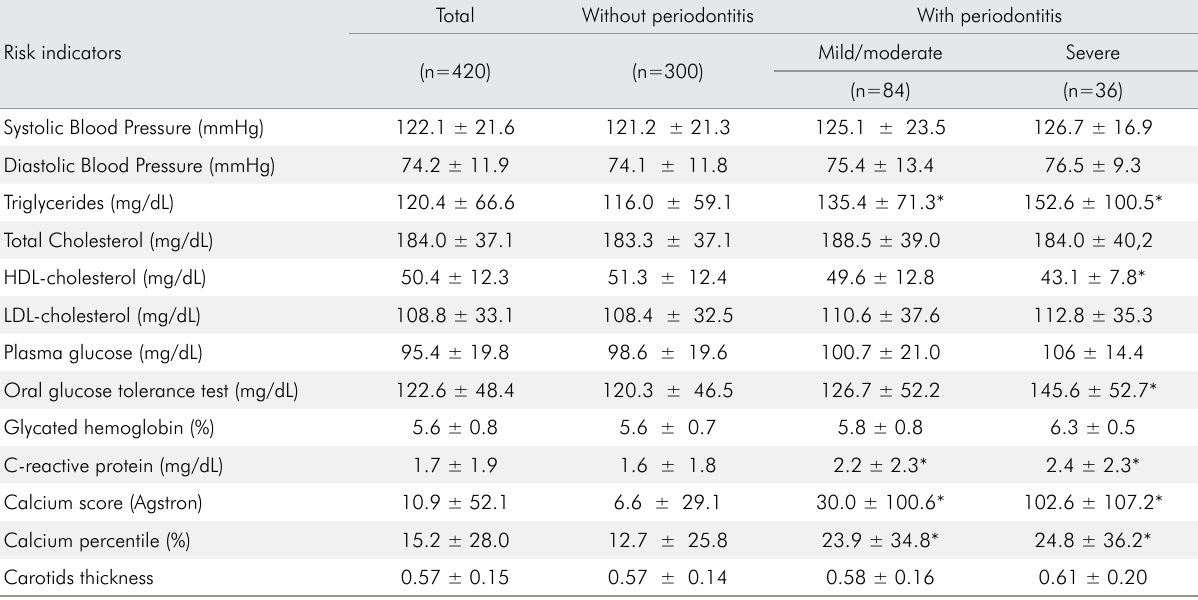
Table 3. Mean and standard deviation of risk indicators for chronic noncommunicable diseases, according to the presence of periodontitis. Advento study. Sao Paulo,